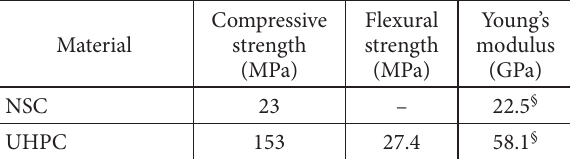
Figure 1. Test system and specimen details (Yin et al. 2017) Table 2. Average mechanical properties of concrete (Yin et al.